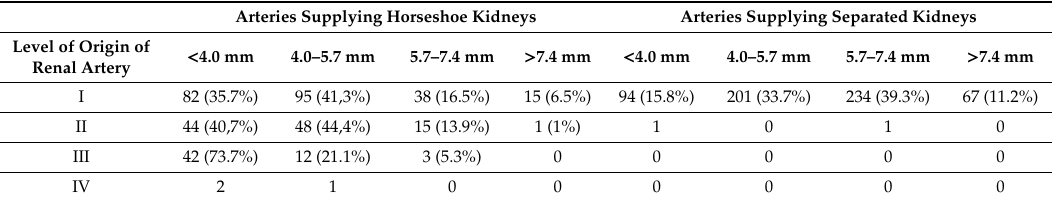
Table 3. Diameter of renal artery with regard to level of origin. Arteries Supplying Horseshoe Kidneys Arteries Supplying Separated Kidneys